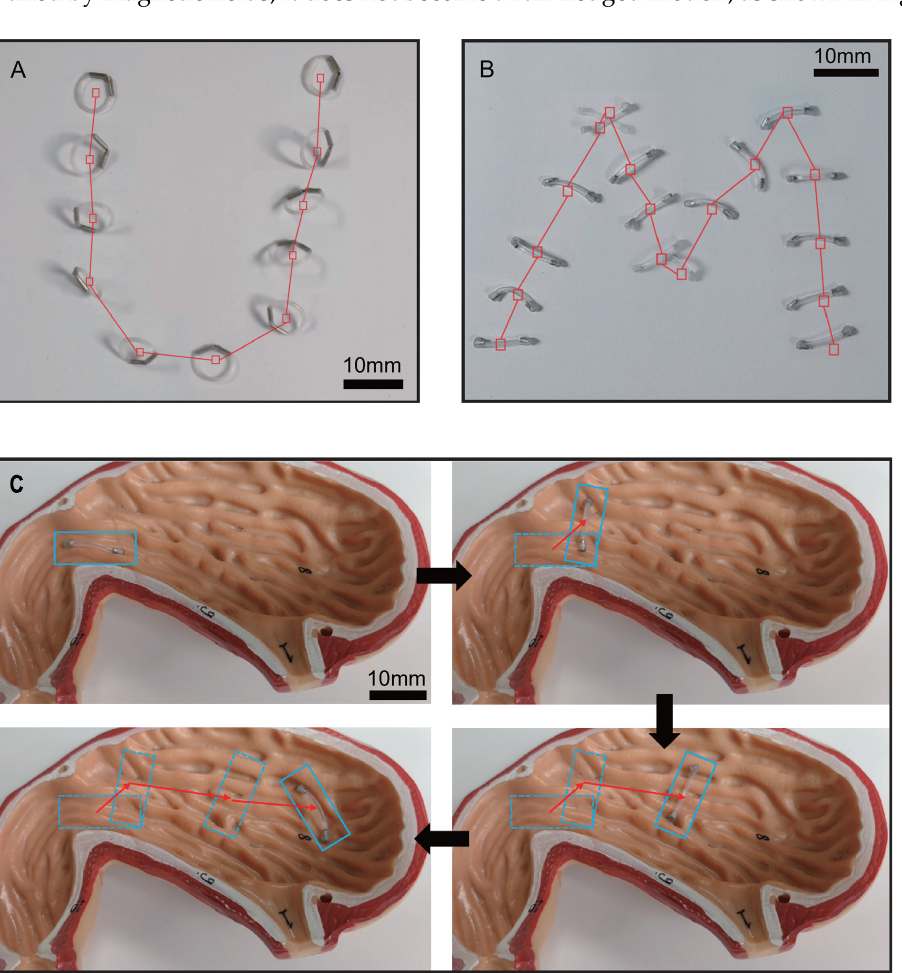
Figure 7. The multimodal motion of MHCMM. ( A ) The “U”-shaped trajectory by circular tumbling; ( B ) the “M”-shaped trajectory by the tumbling motion; ( C ) the MHCMM demonstrated the ability of the tumbling motion to cross obstacles by crawling by path in a human stomach model.